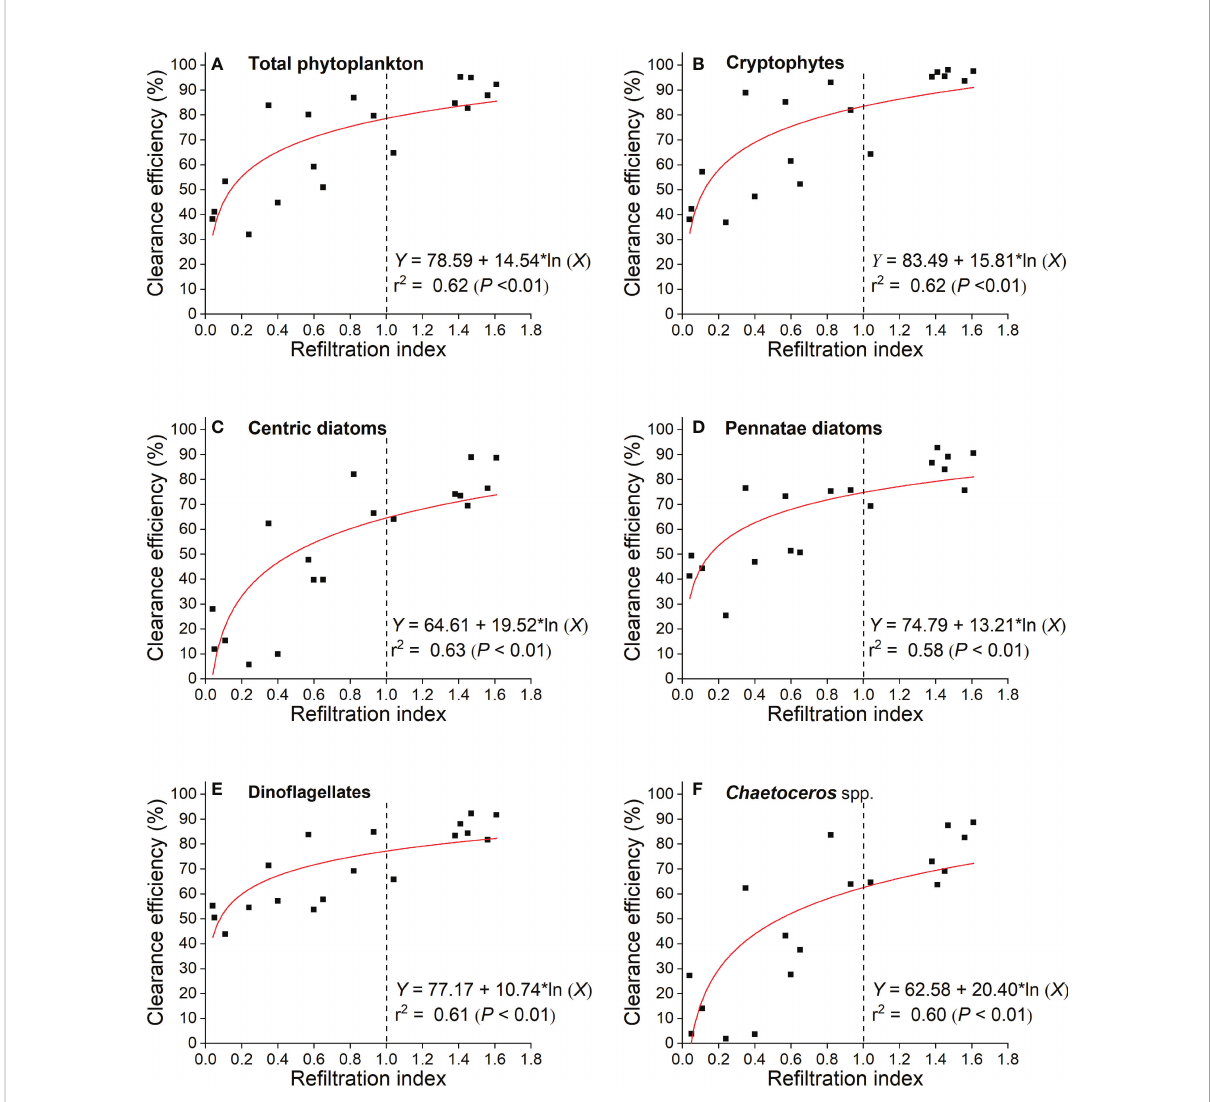
FIGURE 3 Logarithmic relationships between clearance ef fi ciency of phytoplankton cells and re fi ltration index (RI) by M. coruscus